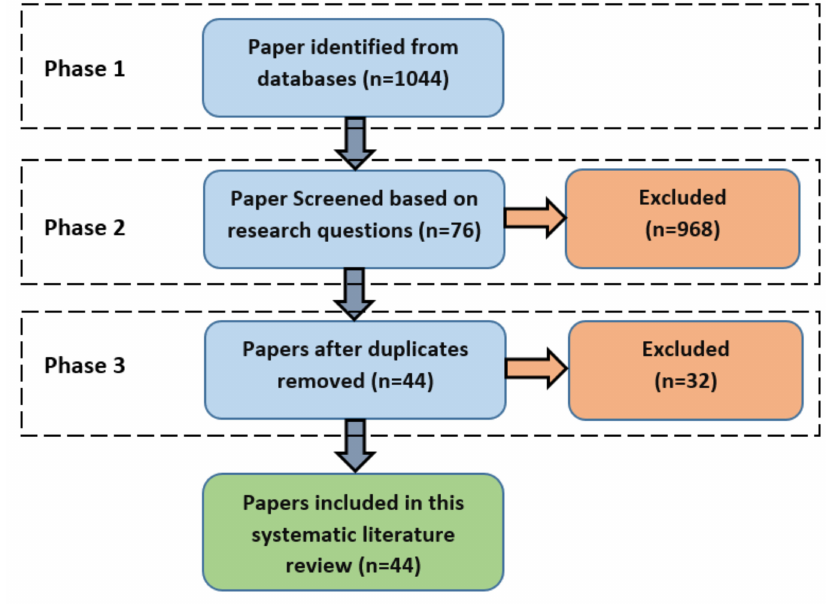
Figure 4. Flow diagram of the search.